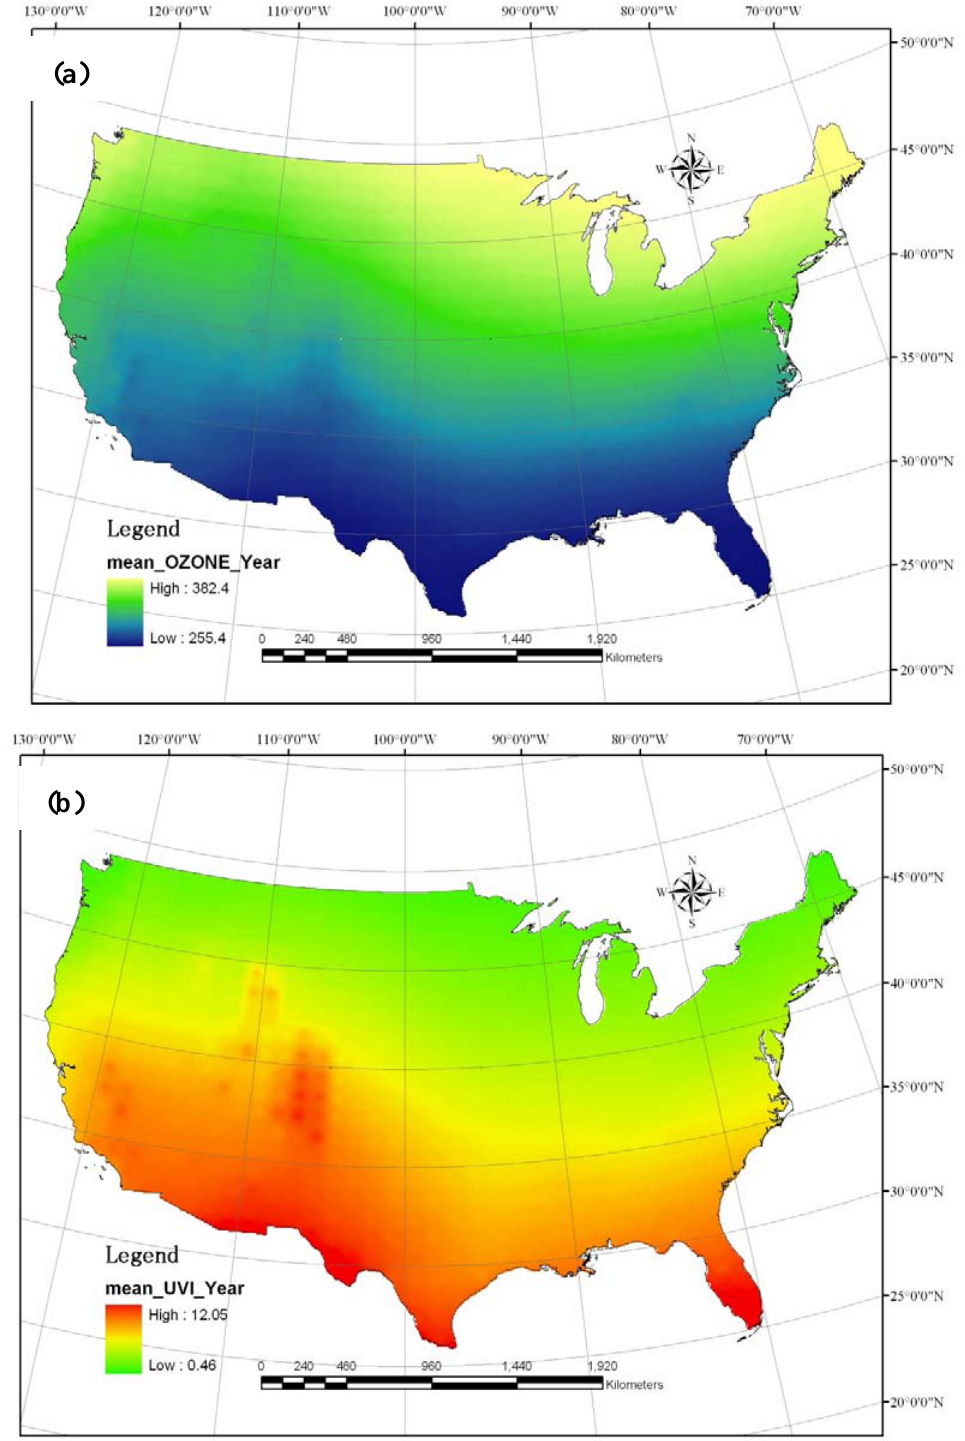
Figure 3. Multi-year mean and standard deviation of UVI and total ozone across the continental USA from 1979 to 2005. (a) Multi-year mean of total ozone; (b) Multi-year mean of UVI; (c) Multi-year standard deviation of total ozone; (d) Multi-year standard deviation of